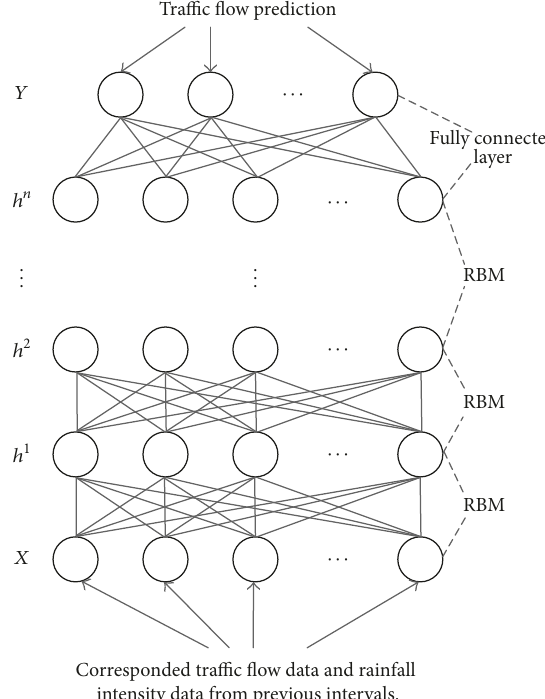
Figure 2: The structure of the R-DBN